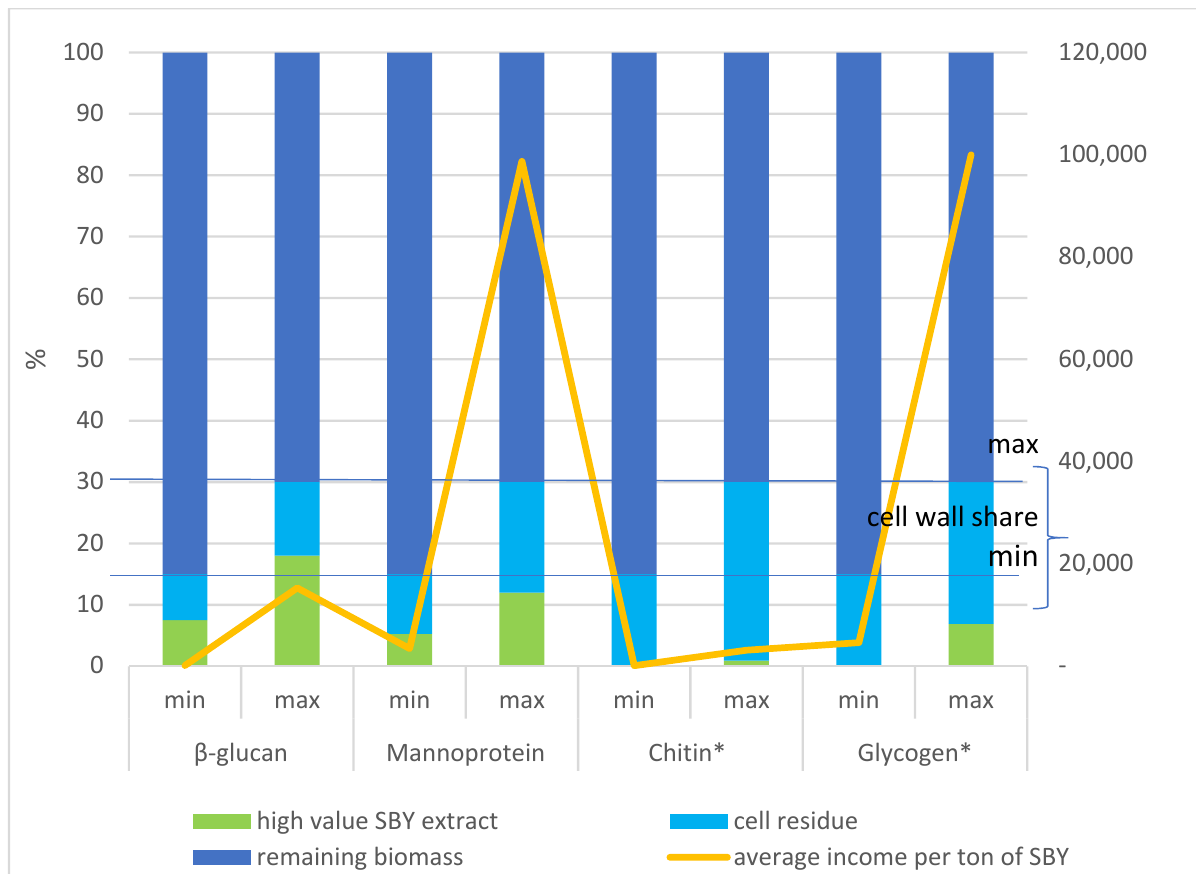
Figure 1. Overview of the marketable share of the total SBY as high-value bioproducts. * SBY chitin and glycogen have not been detected on the market; prices are based on those available on the market and are not discriminated by source.